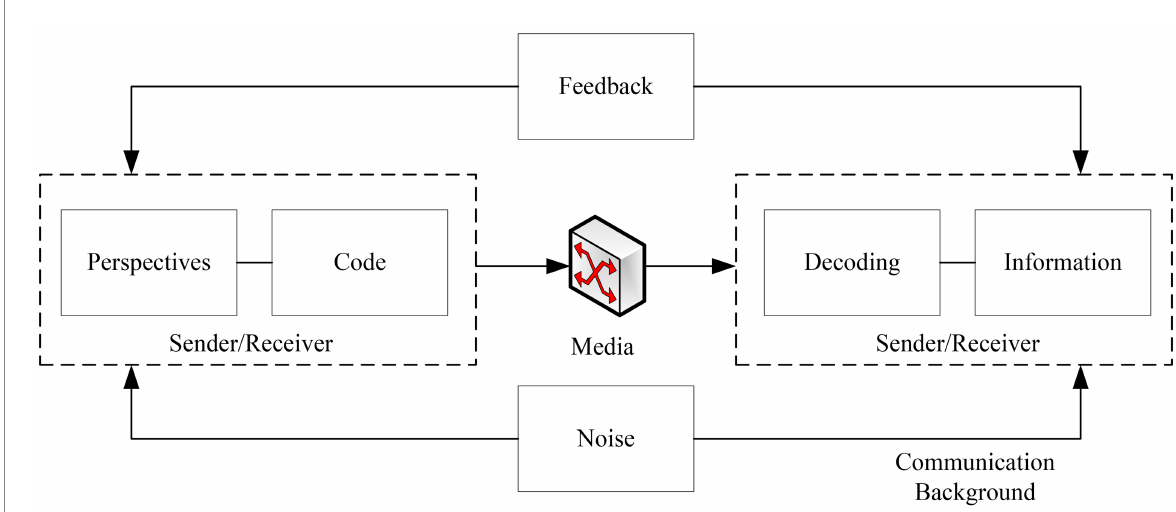
FIGURE 4 Communication element model construction.